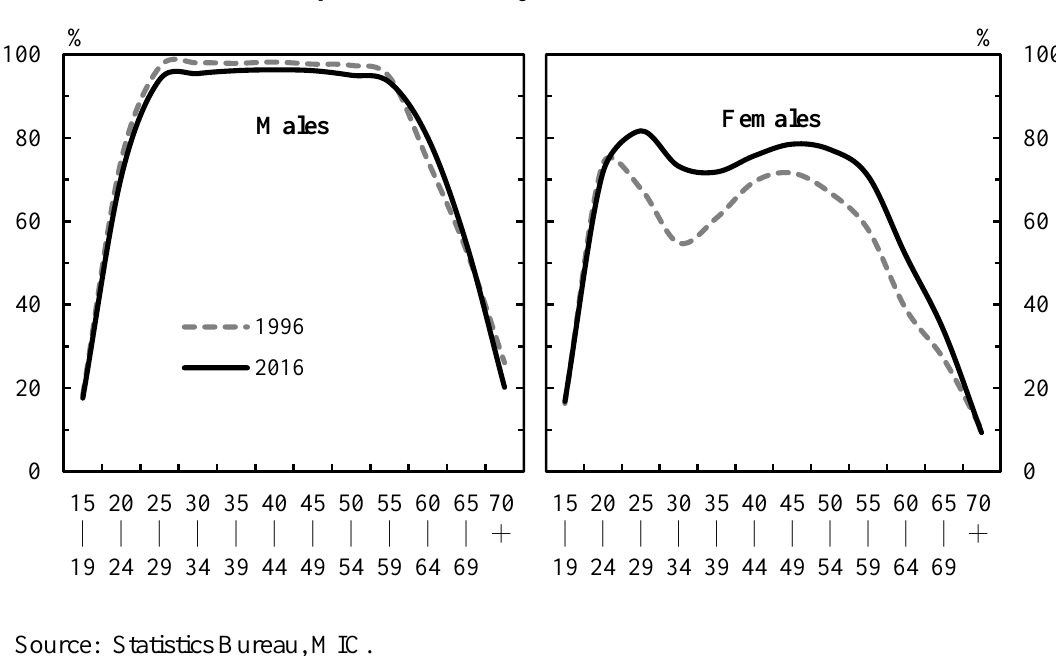
Labour Force Participation Rate by